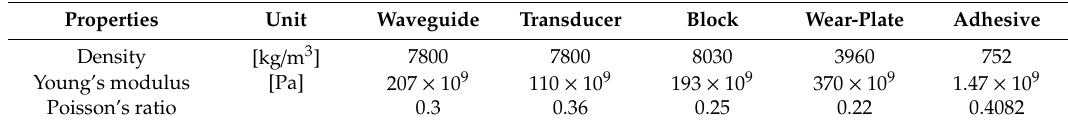
Figure 6. Picture showing the tetrahedral mesh on the transducer (highlighted in blue) and the quadratic mesh on the plate